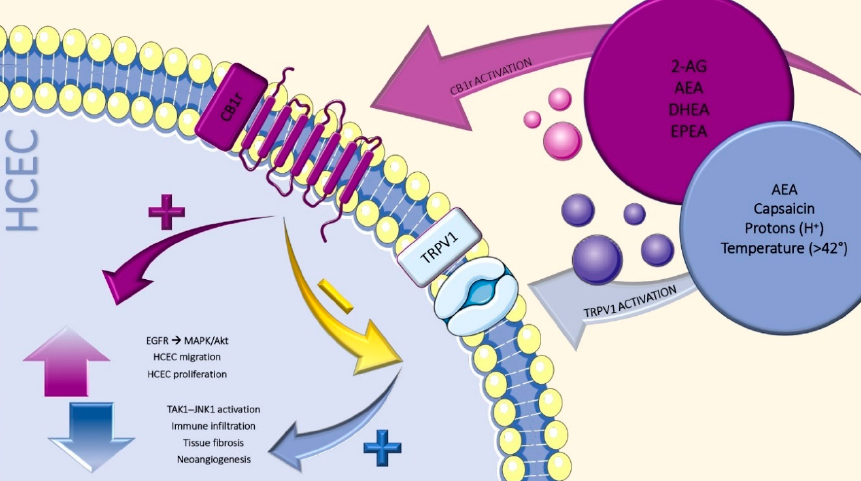
Figure 1. Agonism on cannabinoid receptor 1 (CB1r) by 2-arachidonoylglycerol (2-AG), N -arachidonoylethanolamine (AEA), docosahexaenoyl ethanolamide (DHEA) and eicosapentaenoyl ethanolamide (EPEA) is able to desensitize transient receptor potential cation channel subfamily V member 1 (TRPV1) (yellow arrow) and, via the epidermal growth factor receptor (EGFR)/MAPK, to promote human corneal epithelial cells (HCEC) migration and proliferation (violet pathway). The activation of transient receptor potential vanilloid-1 (TRPV1) elicit TAK1-JNK1 signaling cascade, which in turn is responsible for the promotion of tissue immune infiltration, fibrosis and neovascularization (blue pathway).